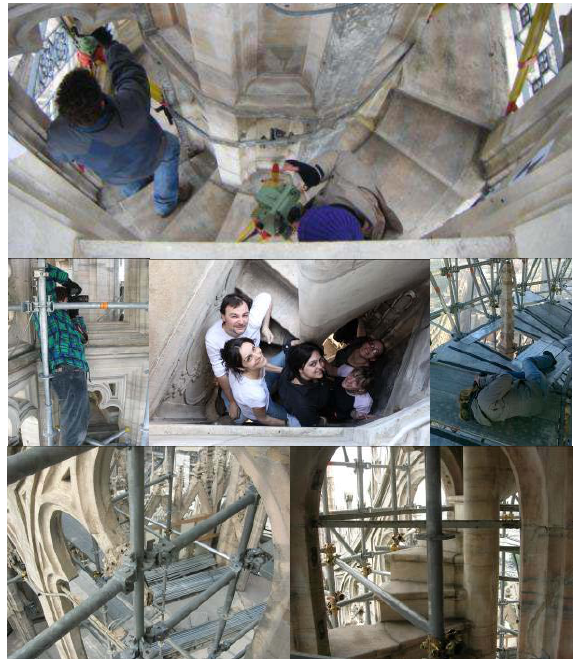
Figure 1: Some fun pictures of survey moments on the spire. The image shows work conditions and the environment to be measured.